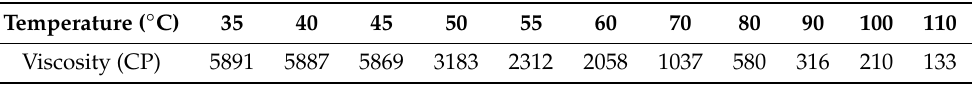
Table 3. Relationship between the viscosity and temperature of the chemical alcohol waster